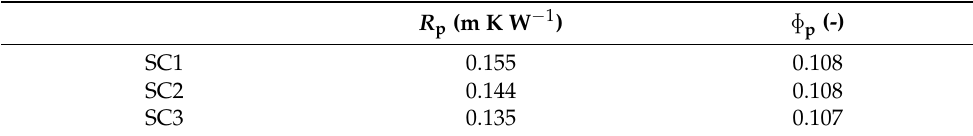
Table 4. Thermal diffusivity deduced from Equation (5) ( R p ) and Equation (6) ( F p ) with deviations from the input value.